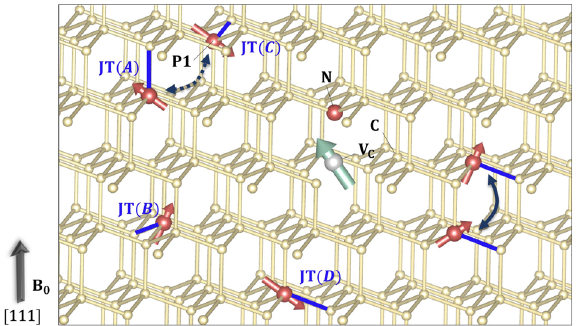
Fig. 1 Diamond NV center in a P1 bath. Schematic of a nitrogen- vacancy (NV) electron spin (green arrow) surrounded by substitu- tional nitrogen impurities (P1 centers). The direction of the NV center is parallel to the external magnetic fi eld B 0 , which points in the [111] direction. The NV center spin interacts with the P1 spins (red arrow), which includes both an electron spin ( S = 1/2) and nuclear spin ( I = 1) via a magnetic dipole-dipole interaction. A P1 center can have one of four different Jahn – Teller axes denoted as JT( A ), JT( B ), JT( C ), and JT( D ), which are represented by a blue bar for each P1